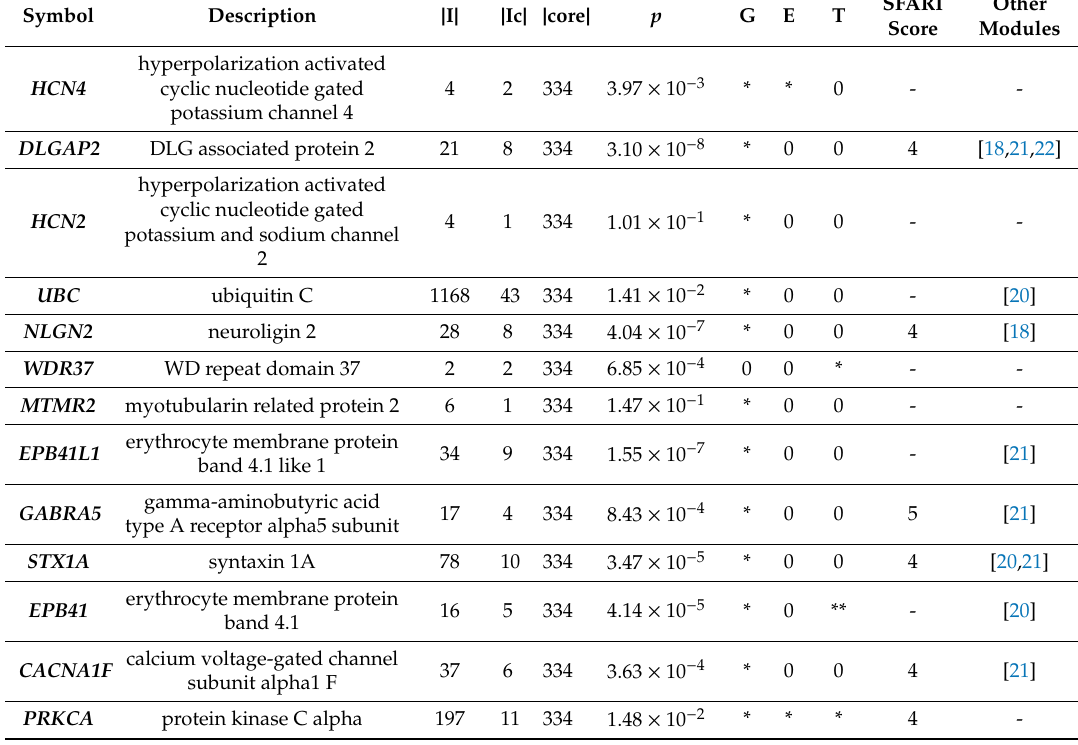
Table 2. The 13 genes that closely interact with the core genes of ASDs. | I | : Number of interactors; | Ic | : Number of interactors that are core genes; p: Hypergeometric probability of observing | Ic | in a hypergeometric experiment; G: Genomics; E: Epigenomics; T: Transcriptomics; ** major; * minor; 0: No evidence; SFARI score: “minimal evidence” (4), “hypothesized but untested” (5); other modules: Reference of gene-networks studies of ASDs in which the gene is mentioned. The total number of genes considered is equal to the interactome size: 12,739 genes.